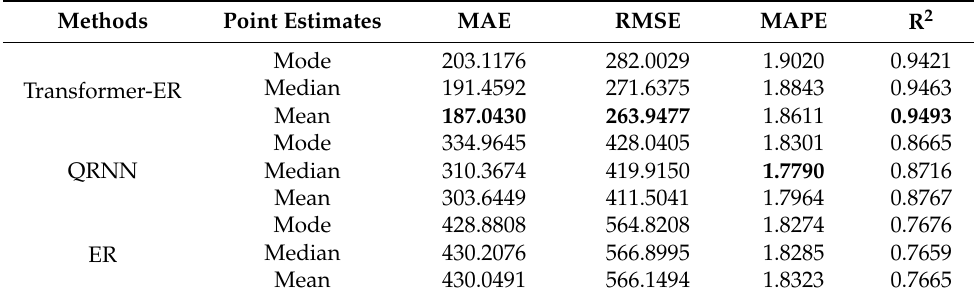
Table 3. The evaluated metrics for point estimation based on several approaches. Methods Point